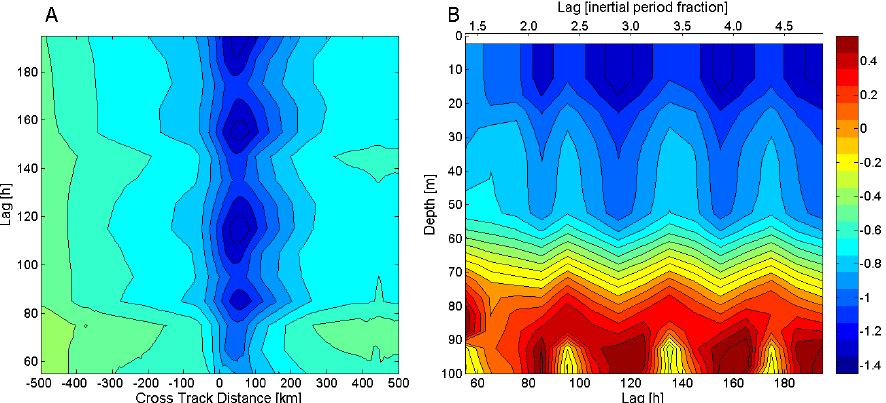
Figure 15. The HHH run results. Panel (A) is SST anomaly. On x axis is cross-track distance in kilometers, and on y axis is lag between Hagupit like forcing in h. Panel (B) is vertical cross section along cold wake ( x = 60km in panel A ). On x axis is lag between Hagupit like forcing in h (lower x axis) and as fraction of inertial period (upper x axis). On y axis is depth in meters. Color scale represents temperature Fig. 15. The HHH run results. Panel A is SST anomaly. On x-axis is cross track distance in 3 anomaly [ ◦ C]. Both panels use the same color km and on y-axis is lag between Hagupit like forcing in h. Panel B is vertical cross section 4 along cold wake (x=60 km on Panel A). On x-axis is lag between Hagupit like forcing in h 5 (lower x-axis) and as fraction of inertial period (upper x-axis). On y-axis is depth in m. Color 6 scale represents temperature anomaly [C]. Both panels use the same color scale. 7